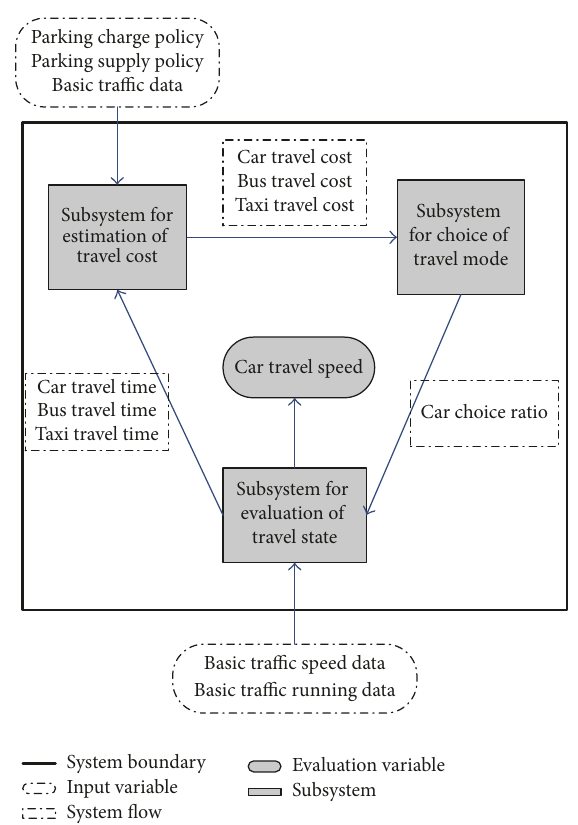
Figure 1: Evaluation model of the combined effects of parking charge and supply